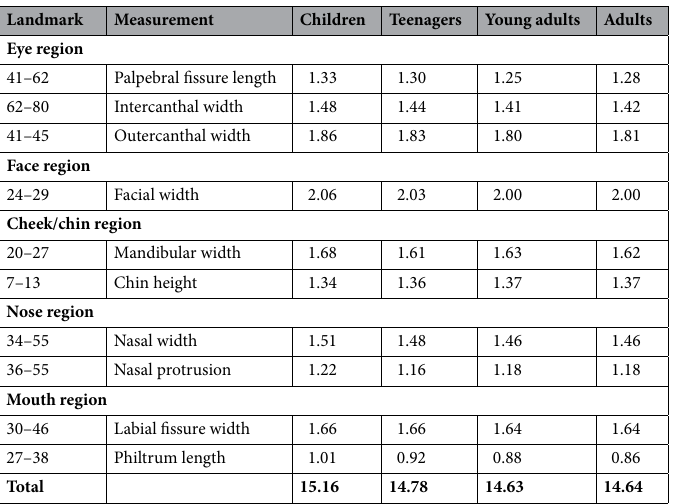
Table 2. Anthropometric measurement for all age groups. The bold text under Landmark column represents the observed facial regions while the bold text under Total row represents the aggregate of each age group.